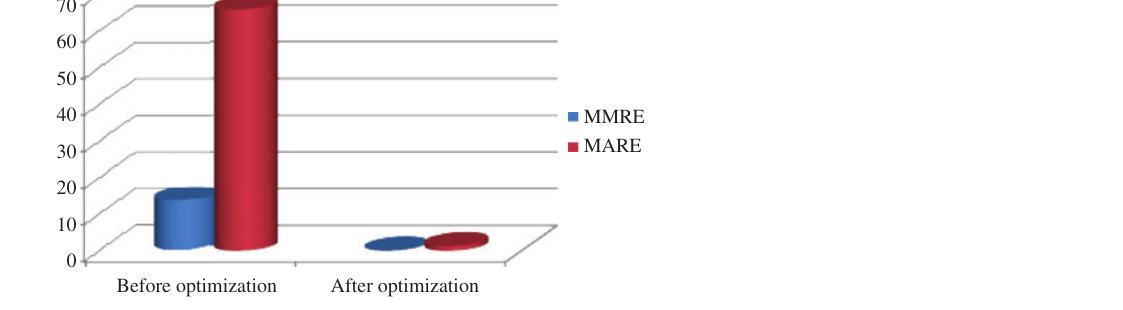
Figure 4: Graphical Representation of the MMRE and MARE Values Before and After Optimization for the Desharnais Dataset.